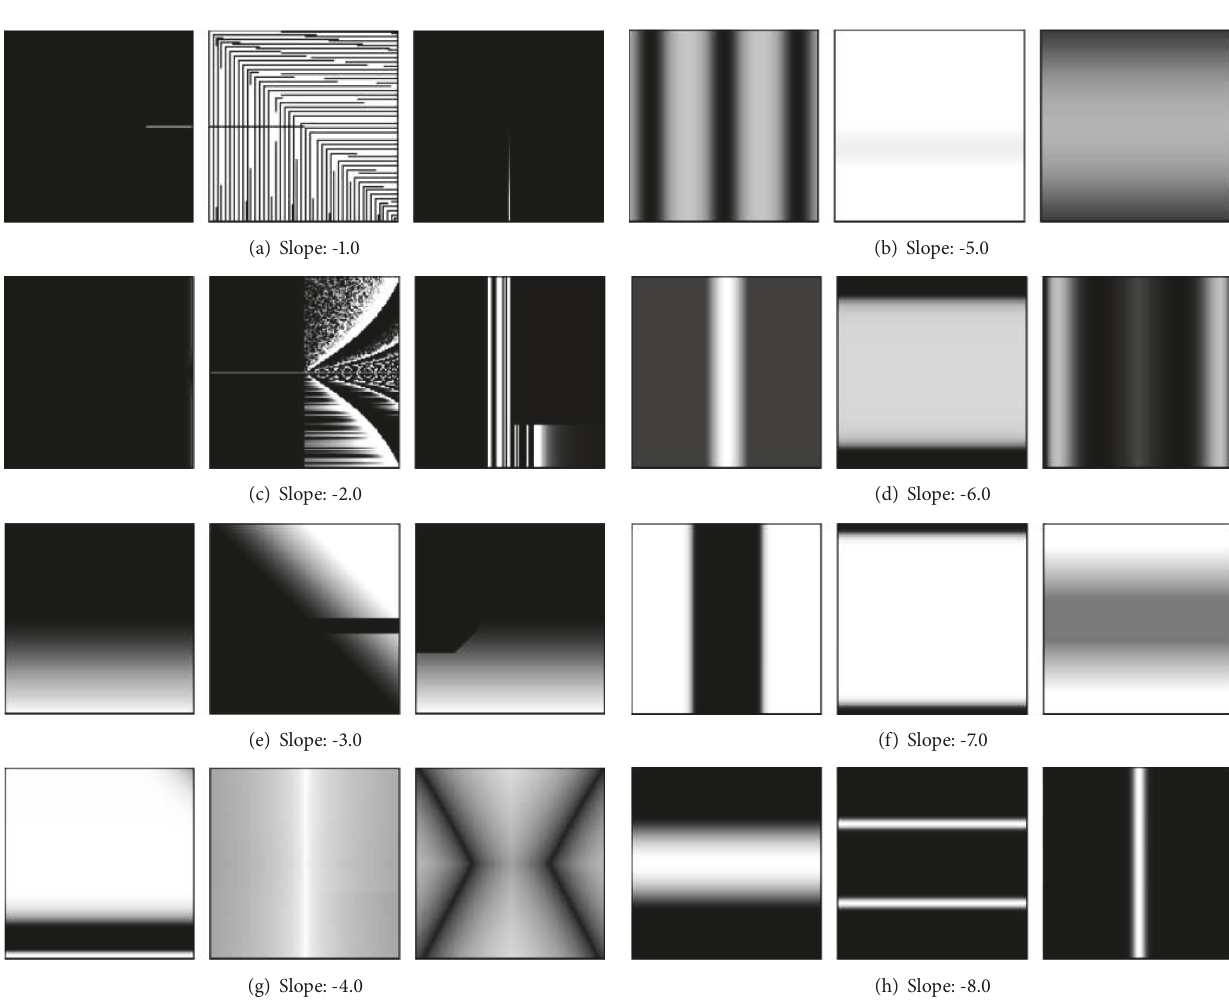
Figure 4: Regressed slope example evolved images. Target slopes were specified at regular integerintervals from −1.0 to −8.0 . Best candidates per run had mean 𝜀 < 1.0𝐸 −5 , except for the last target, where it was found that errors greatly increased when target slope exceeded -7.0. These initial runs relied on Cartesian coordinate variables (omitting the polar coordinate